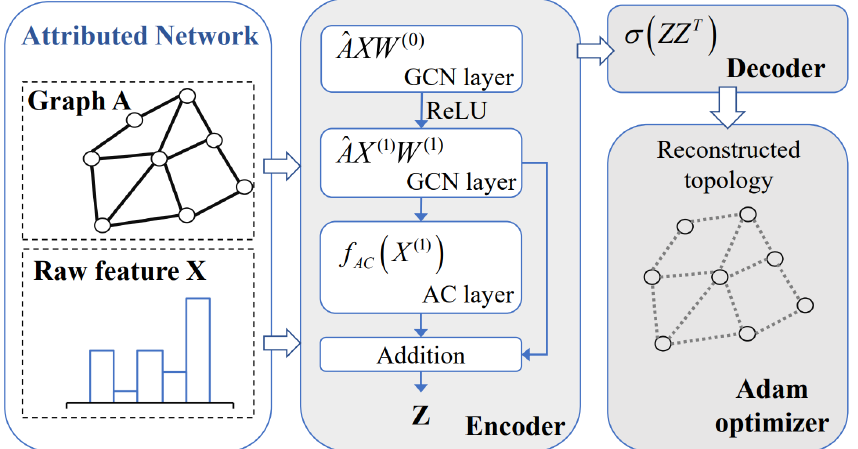
Figure 1. The GAE-AC architecture. The left part is the input of the model, including the graph and features; the middle part is the encoder part, the first two layers are the traditional GCN layer, the third layer is the attention-with-cluster layer, and finally, it links to a residual block; the right part is the decoder and loss function of